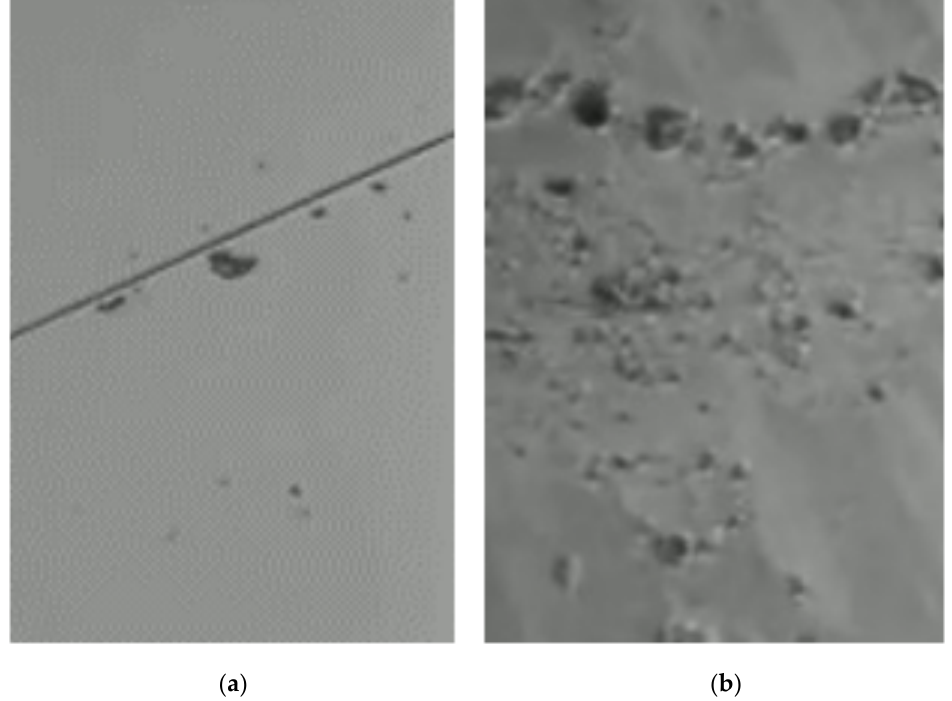
Figure 1. ( a ) Scratch defects in unpa(cid:308)erned wafers; ( b ) particulate contamination in unpa(cid:308)erned wafers.